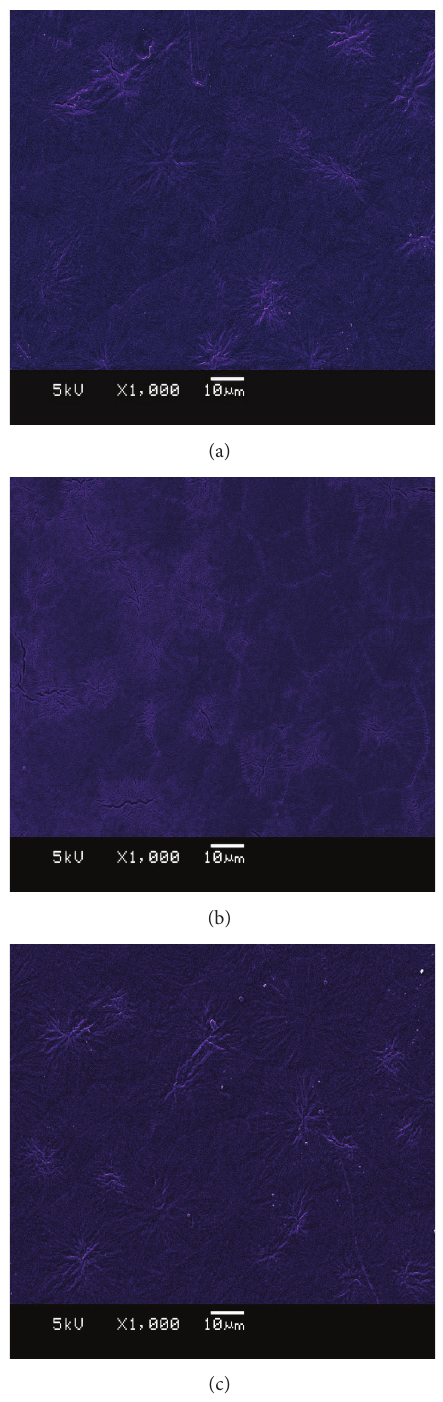
Figure 4: Optical micrographs (transmission mode) of (a) neat PP, (b) PP/Oil-g-CF composite, and (c) PP/Silane-g-CF composite with 4.0 wt% filler loading (scale bar 100 𝜇 m).